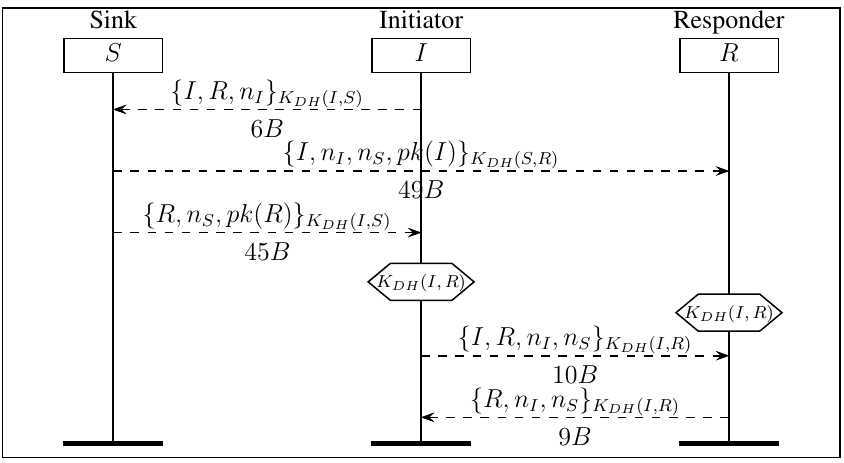
Figure 3. MKE : Multi-hop Key Establishment using the sink S to deliver public keys. S K ( I, R ) is computed by the initiator I and the responder R . DH